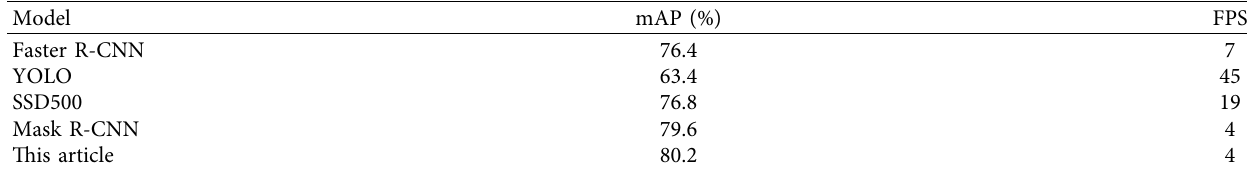
Table 3: Comparison of the performance of each